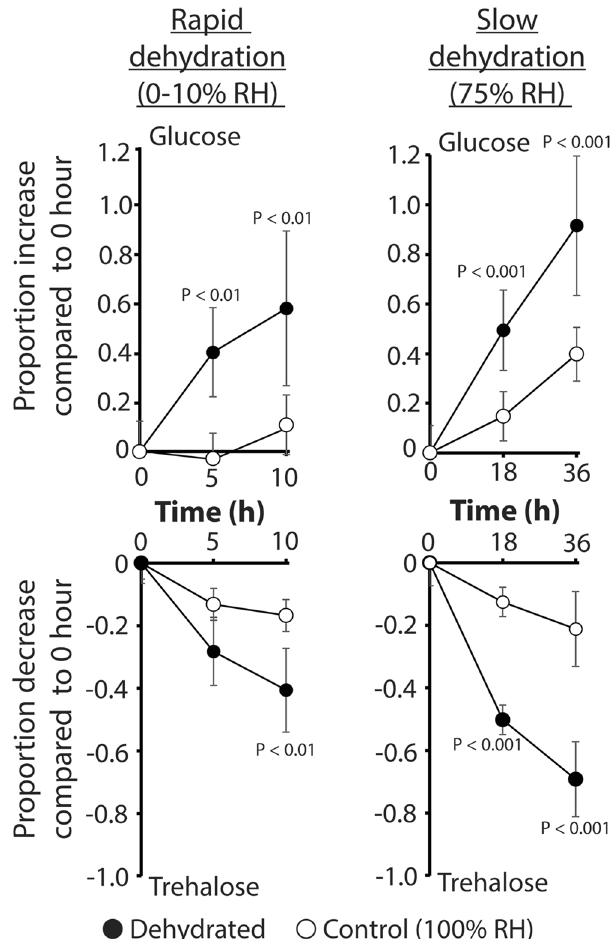
Figure 3. Glucose and trehalose changes are related to the rate of dehydration for C . pipiens females. Rapid and slow dehydration differentially altered levels of glucose and trehalose. Mean ± SE for 10 replicates of samples from four-five mosquitoes at each time point. Statistical values refer to the control versus dehydrated mosquitoes at each time